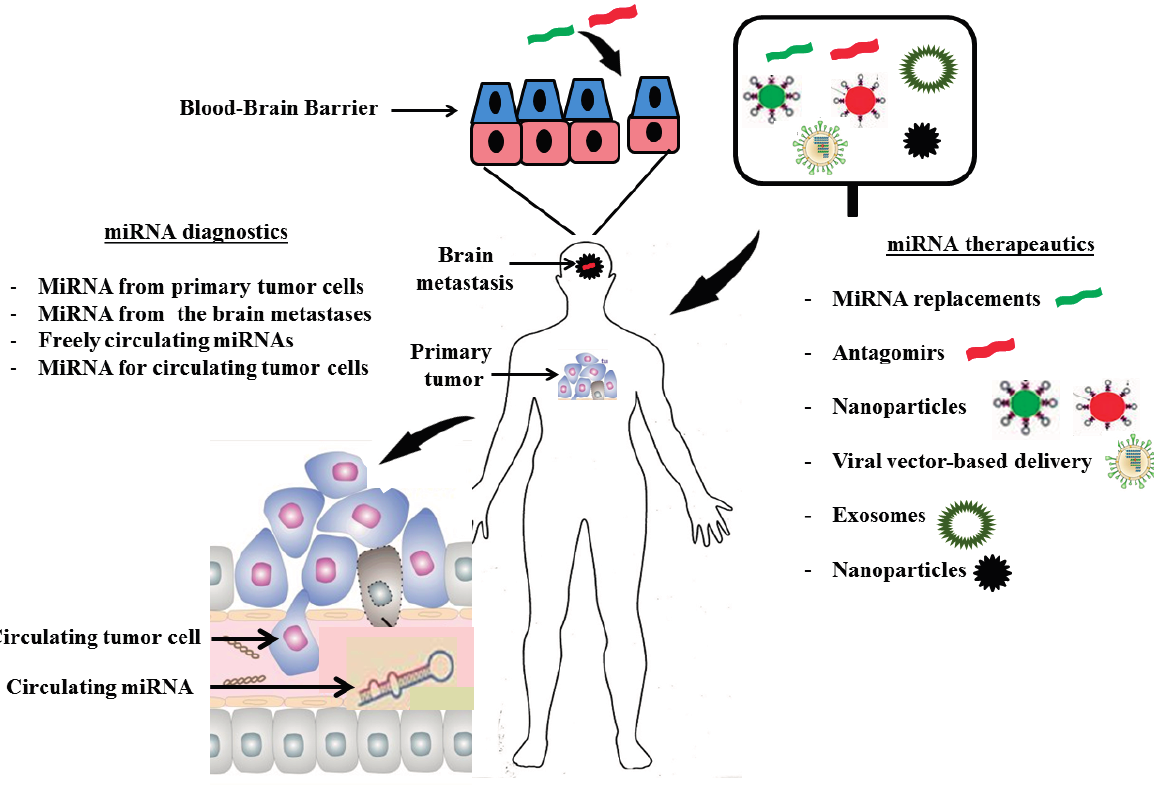
Figure 3. MiRNA diagnostics and therapeutics for brain metastases. A synthesized antisense nucleotide (antagomir, red) or miRNA replacement (green) is loaded onto a delivery system. The delivery system can be a viral vector such as adenovirus or a non-viral liposome or nanoparticle. The preparation is then administered intravenously to the patient with a metastatic brain tumor and remains stable in the blood stream. The compound crosses the blood–brain barrier and reaches the tumor cells and undergoes endocytosis to the intracellular space. The antagomir is then released from the delivery system which gets degraded. The antagomir binds to the miRNA of interest in blue and antagonizes its oncogenic effect which eventually leads to apoptosis and tumor regression